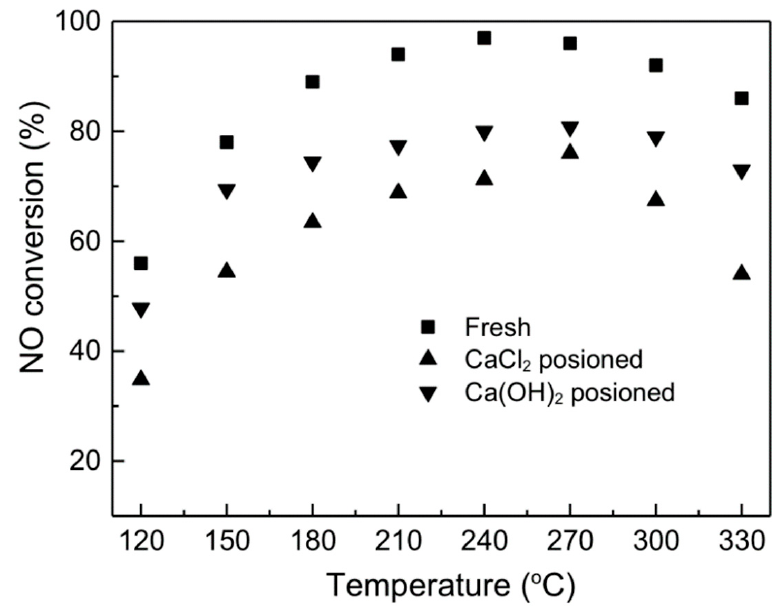
Figure 7. NO conversion over fresh and different Ca-poisoned catalysts [57].